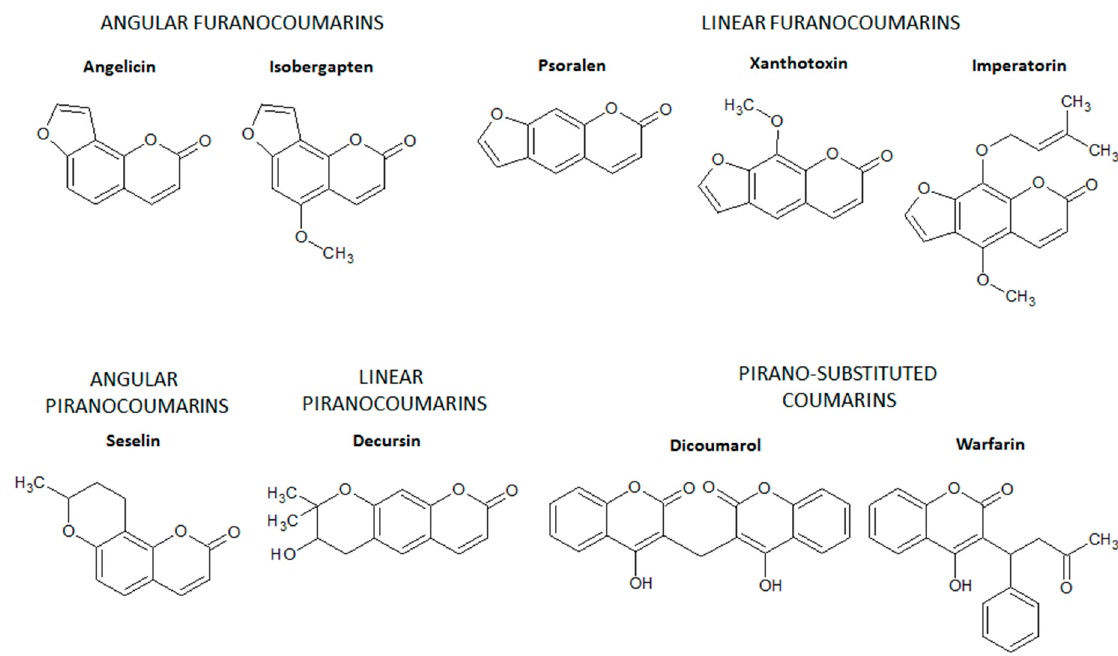
Figure 3. Chemical structures of angular and linear furanocoumarins, angular and linear pyranocoumarins, and pyrano- substituted coumarins. Chemical structures were drawn using ACD/ChemSketch software.